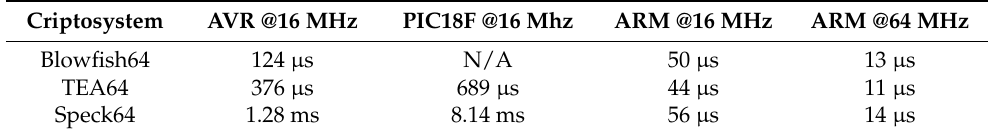
Table 2. CPU Processing Times for